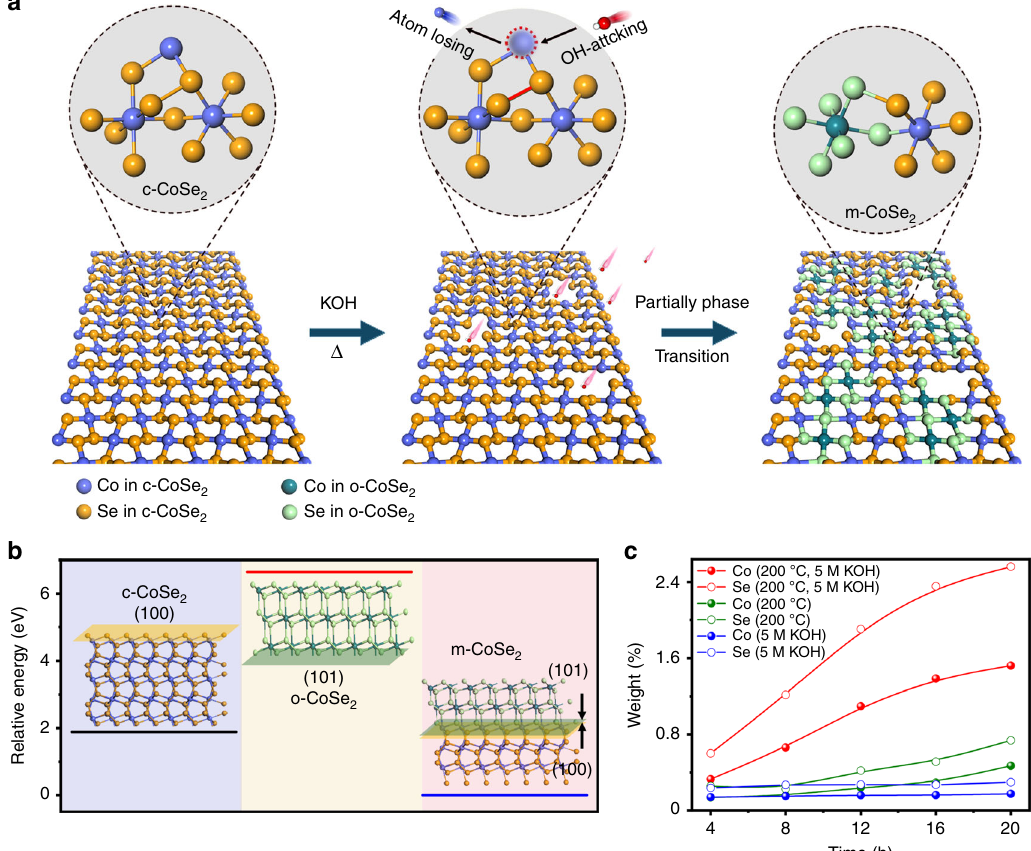
Fig. 1 Structural phase transition in c-CoSe 2 . a Schematic illustration of the defects-mediated structural phase transition from c-CoSe 2 to m-CoSe 2 through an alkali-heating approach. b Surface/interfacial energy diagram of c-CoSe 2 (100), o-CoSe 2 (101), and m-CoSe 2 (100||101), respectively. Insets in b show the corresponding crystal structures. c ICP-AES results compare the Co and Se leaching from c-CoSe 2 at different reaction conditions, revealing that KOH and temperature are critical to drive the structural phase